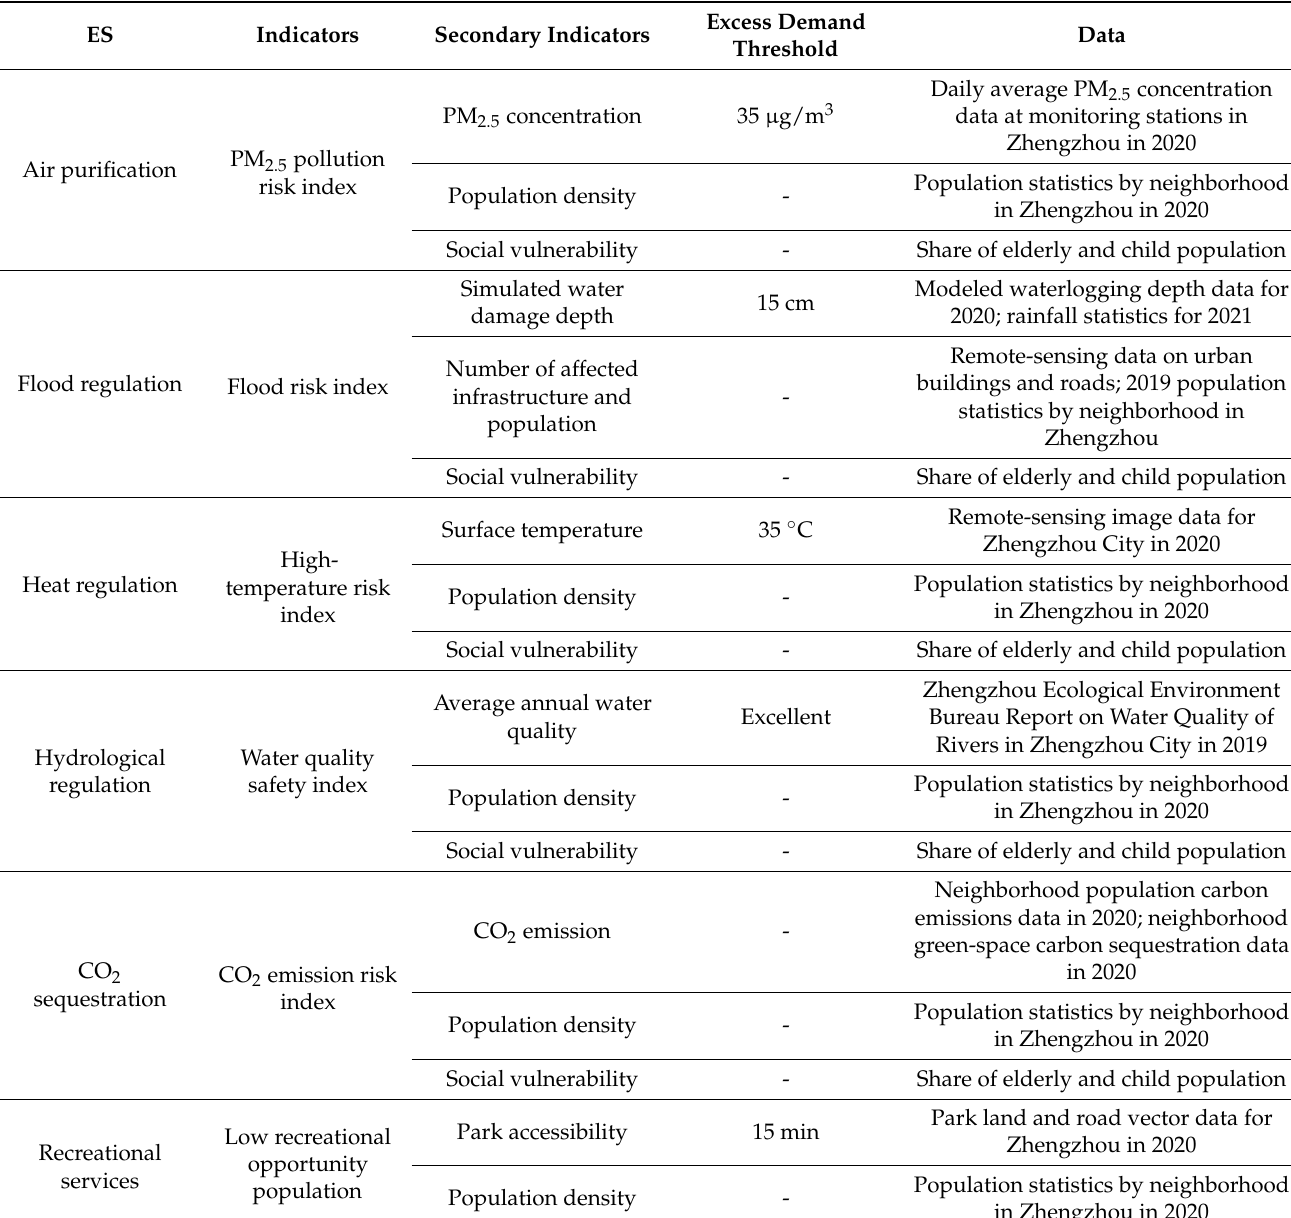
Table 1. ES excessive demand evaluation indicators and demand